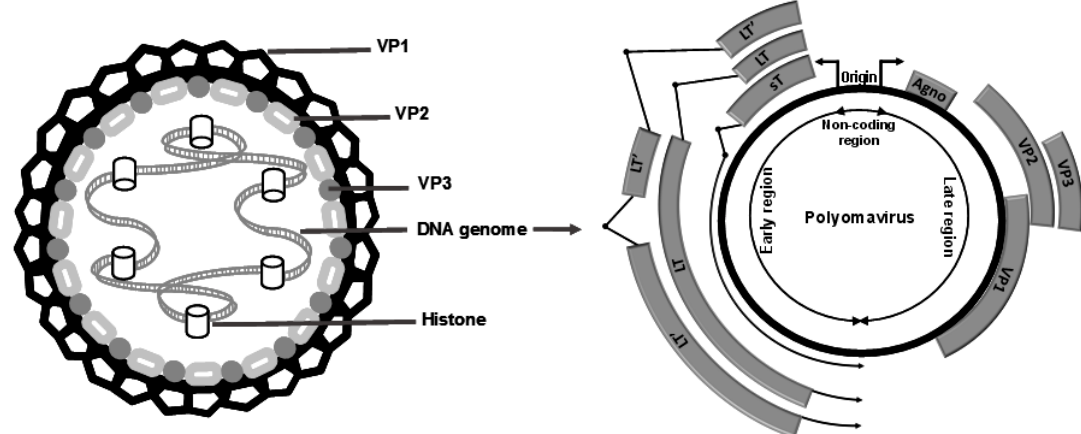
Figure 1. Human PyV particles are composed of 72 pentamers of the capsid protein VP1, with one of the minor capsid proteins VP2 or VP3 in the center of each pentamer. The human PyV genome is divided into three regions: a non ‐ coding region, containing the early and late promoters, transcription sites and the origin of replication; an early region encoding small T antigens (sT), large T antigens (LT) and alternatively ‐ spliced LT antigens (LT’); and a late region encoding the viral structural proteins VP1, VP2 and VP3. Among human polyomaviruses, only BKPyV and JCPyV encode an agnoprotein (agno) upstream of VP1. Merkel cell PyV (MCPyV) does not encode the minor capsid protein VP3.